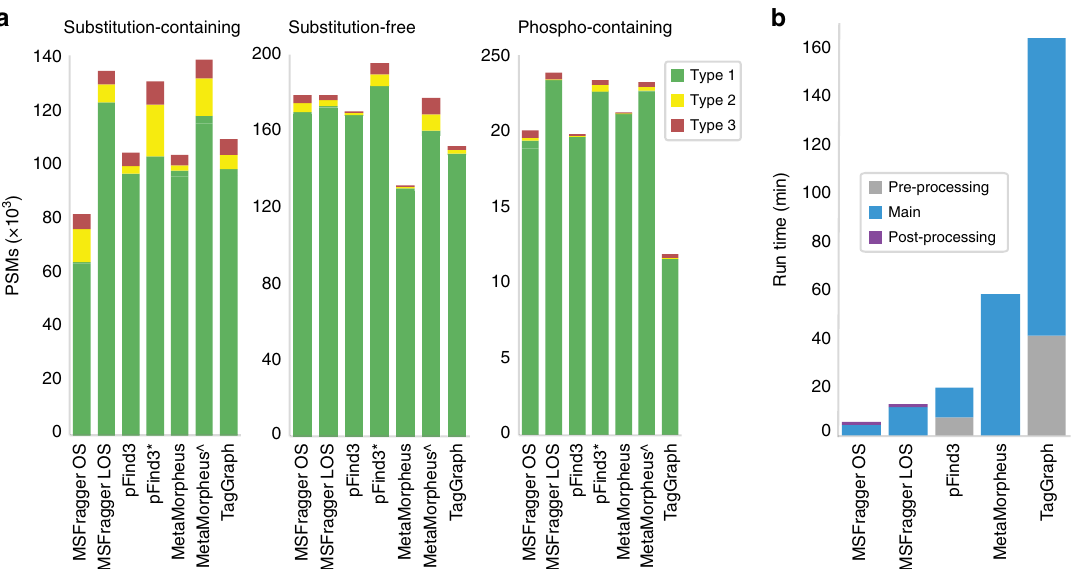
Fig. 3 Comparison of search results and run times across tools. a Numbers of identi fi ed PSMs from MSFragger open search (MSFragger OS), MSFragger with localization-aware open search (MSFragger LOS), pFind3, pFind3 with mixture spectra (pFind*), MetaMorpheus, MetaMorpheus with precursor deconvolution (MetaMorpheus^), and TagGraph. Green indicates PSMs that agree with the high con fi dence list (Type 1). Yellow indicates PSMs with a different sequence, but one identi fi ed by other spectra in the high con fi dence list (Type 2). Red indicates spectra with a sequence that is not found in the high con fi dence list (Type 3). Left: numbers of substitution-containing PSMs from searching the simulated data. Middle: numbers of substitution-free PSMs from searching the simulated data. Right: numbers of phospho-containing PSMs from the phosphorylation-enriched data. b Average time (in minutes) taken by each tool to perform open search analysis on one representative mzML fi